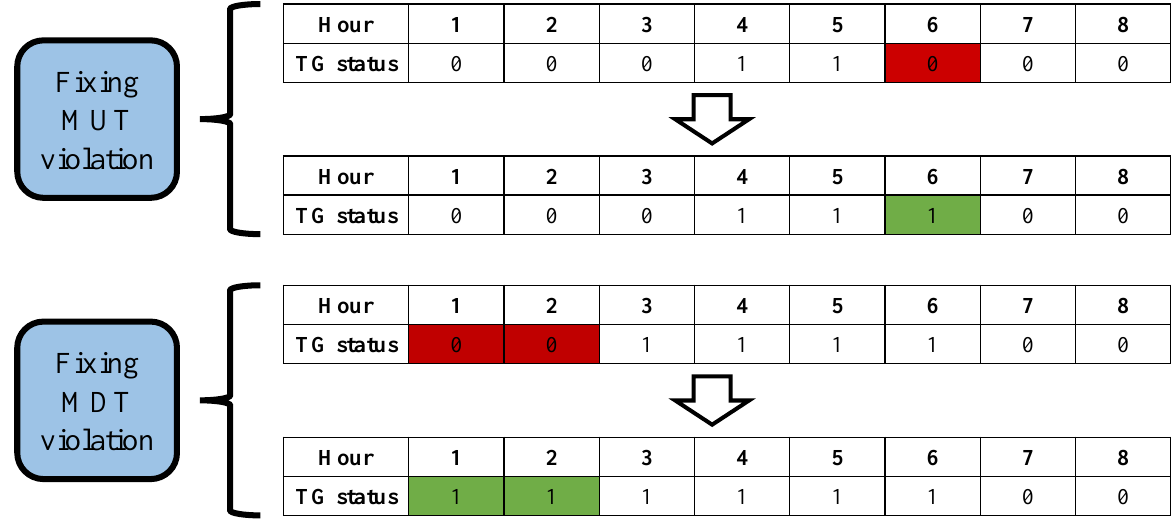
Figure 1. Illustrative example of the feasibility-fixing process.